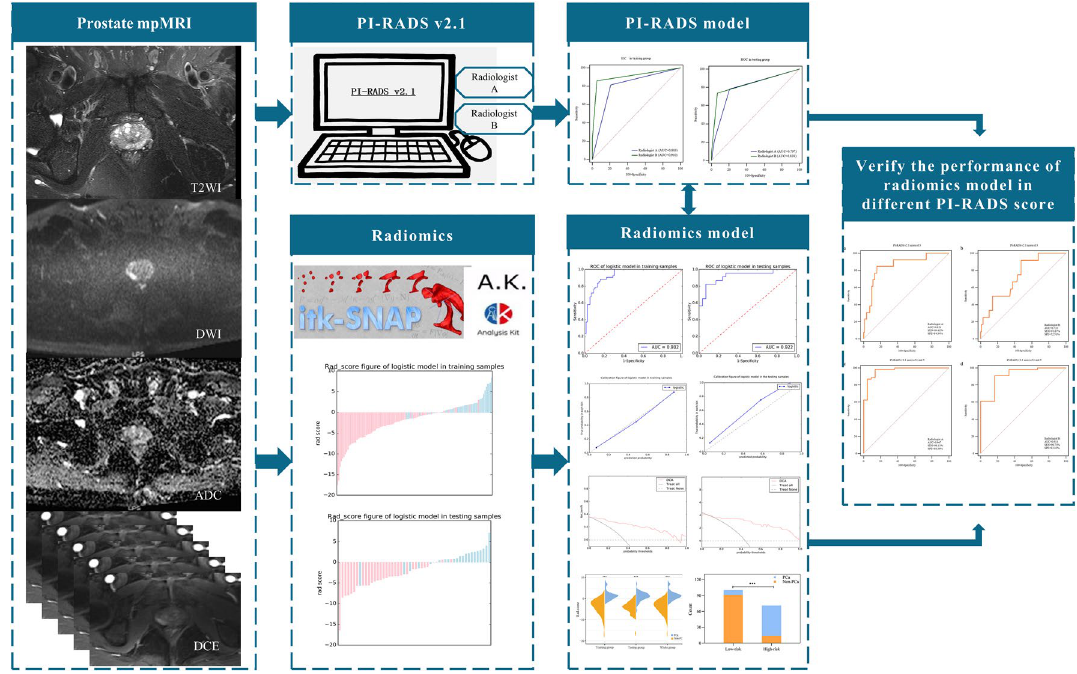
Figure 6. The radiomics